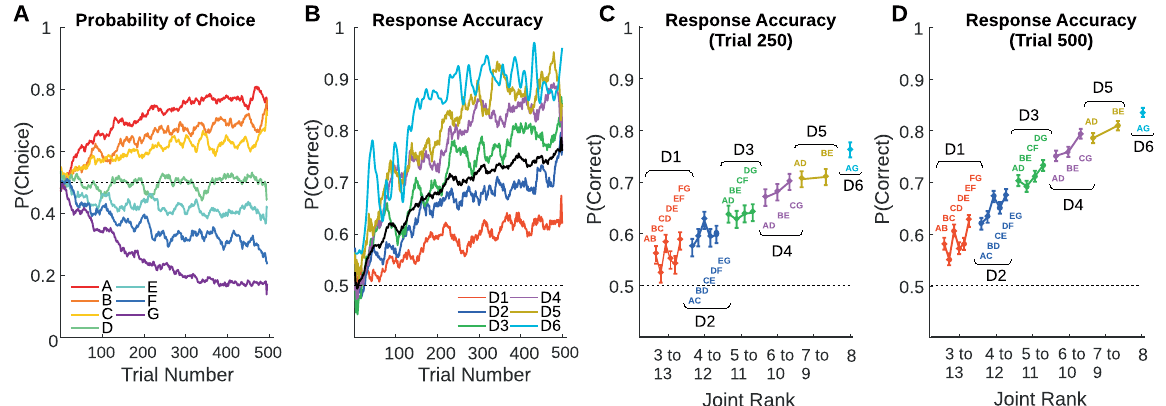
Figure 1. Behavioral Performance. Response accuracy (proportion correct) was averaged over sessions, but separated by trial number, symbolic distance, and joint rank. Data were smoothed using a 25 trial moving window. ( A ) Probability of choosing each item during the first 500 choice trials. ( B ) Mean accuracy during the first 500 trials (black line), as well as accuracy sorted by symbolic distance (colored lines). ( C ) Estimated accuracy for each pair at trial 250 sorted by joint rank and symbolic distance. Error bars are standard deviation across sessions. ( D ) Estimated accuracy at trial